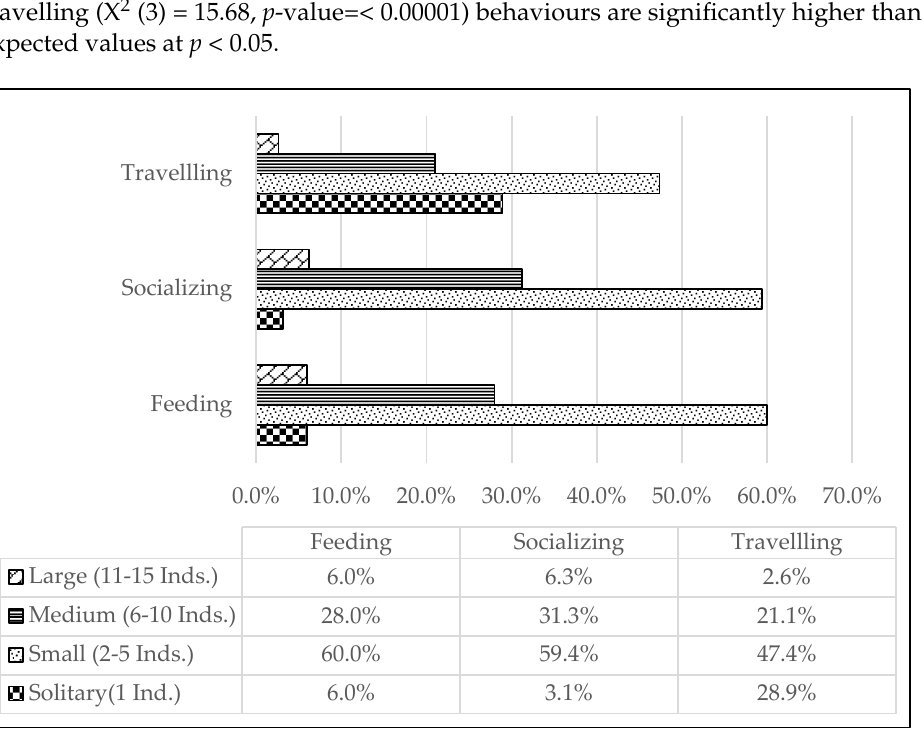
Figure 6. The percentage of the number of solitary (n = 12), small (n = 35), medium (n = 14) and large (n = 3) groups displaying feeding, socializing and travelling behaviours.